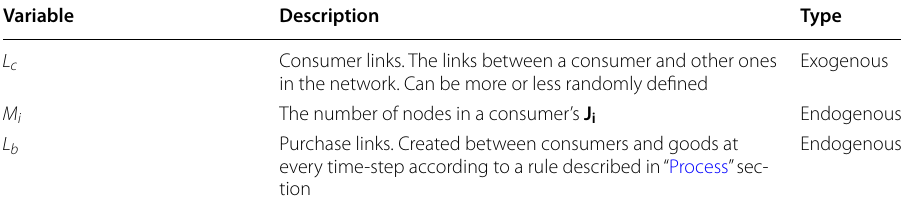
Table 3 Types of links Variable